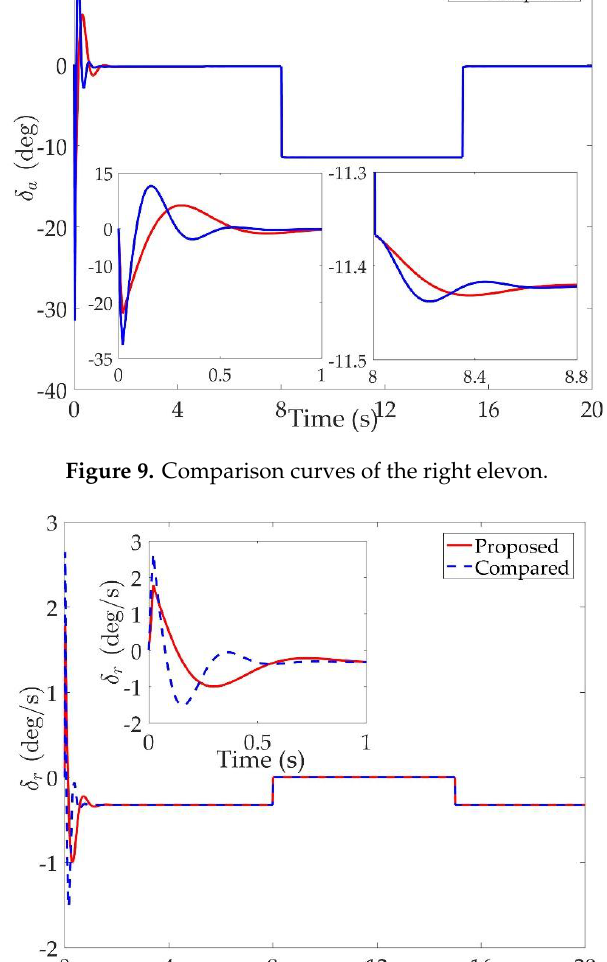
Figure 10. Comparison curves of the rudder.